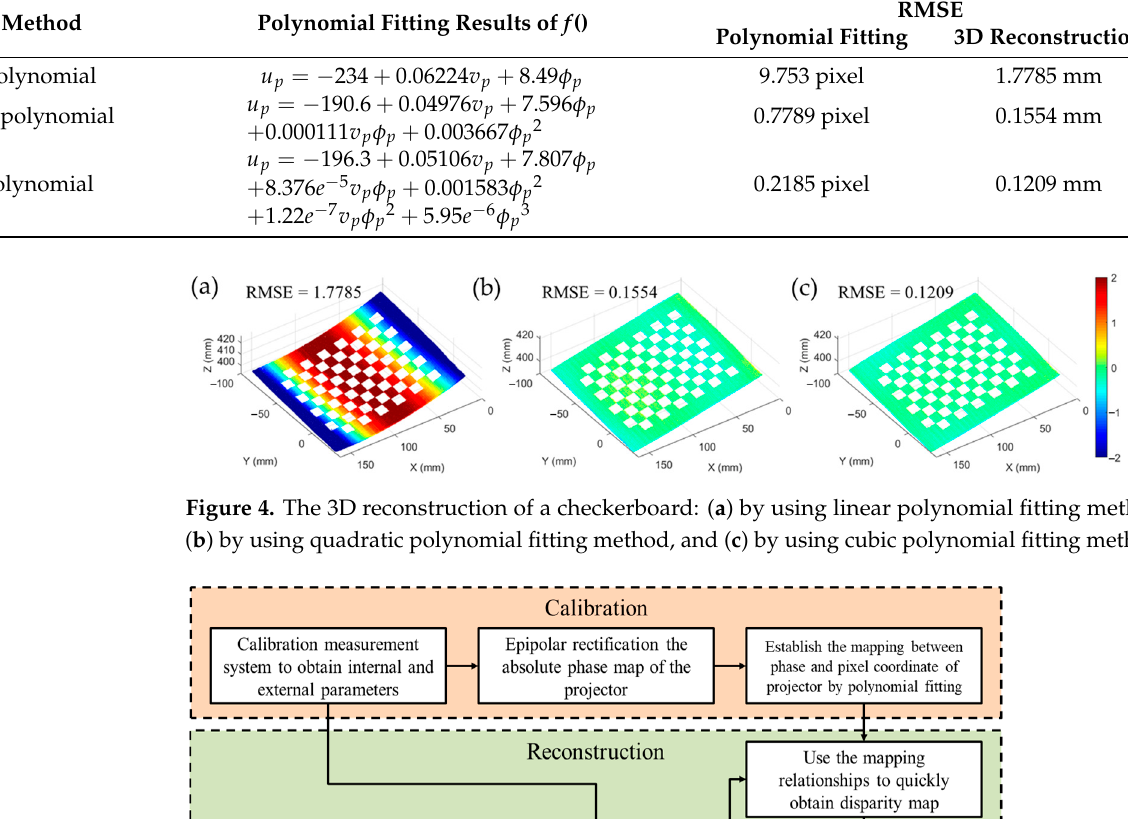
Table 1. Polynomial fitting results with different fitting methods.